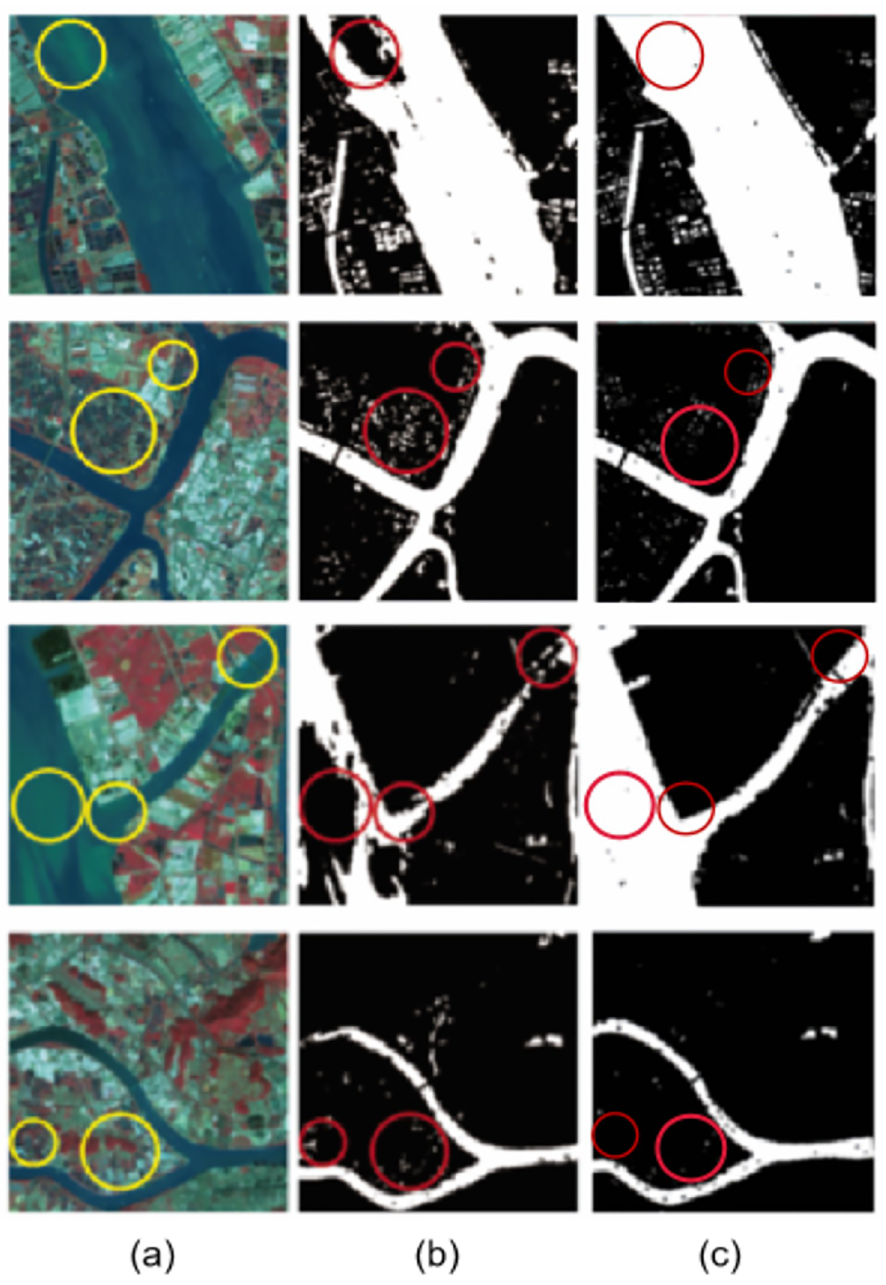
Fig 16. Prediction results under different data processing methods. Comparison of the prediction results for single input and multi-scale input. ( a ) is the original image, ( b ) is a single input, and ( c ) is a multi-scale input result. Reprinted from www.gscloud.cn under a CC BY license, with permission from Dr. Qinghui Lin, original copyright 2019.